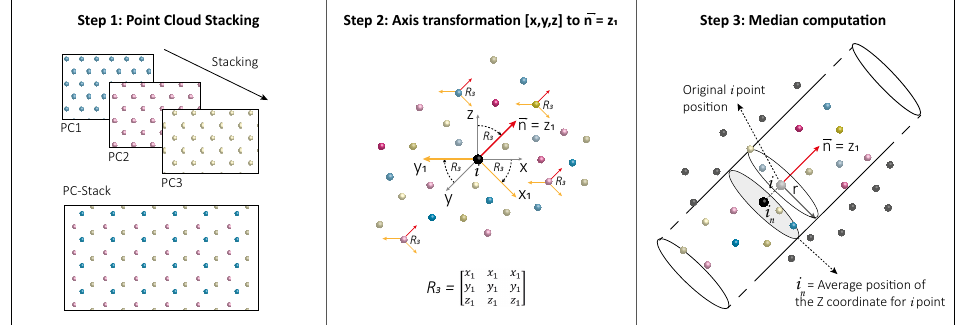
Figure 1. The three steps developed by the Point Cloud Stacking algorithm. Step 1: All points are stored in the PC-Stack cloud. Step 2: Coordinates system change. Step 3: Point averaging on the normal